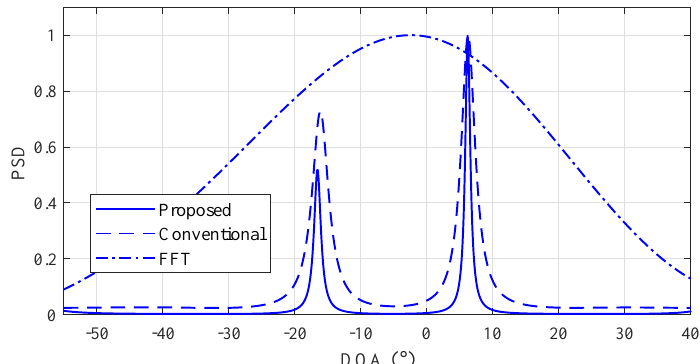
Figure 17. Experimental results of FFT, conventional, and proposed MUSIC